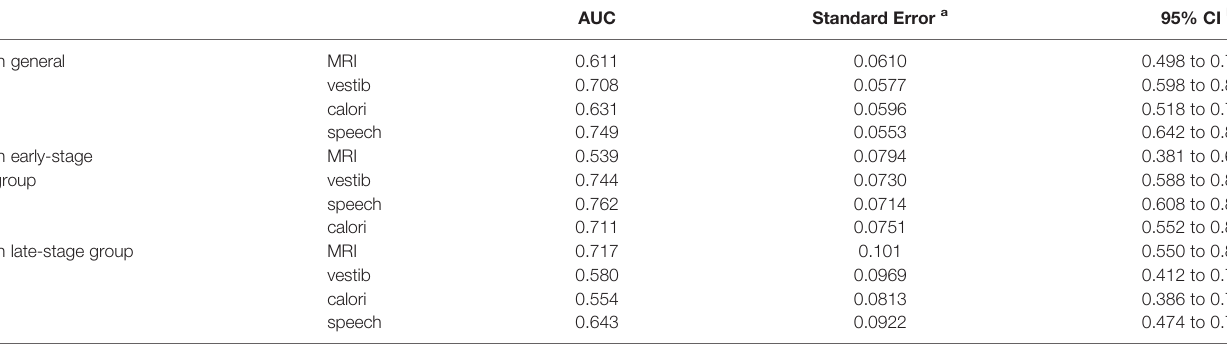
TABLE 3 | AUC of different variables in general/in early-stage group/in late-stage group.